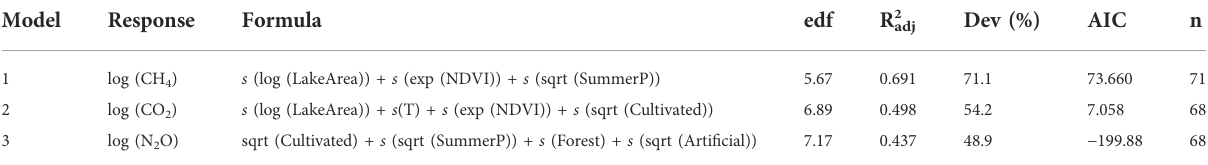
TABLE 1 Results of the generalized additive models (GAMs) calculated for biogenic saturation of CH 4 , CO 2 , and N 2 O using both linear terms and smoothers (indicated with s before the variable). Edf: effective degrees of freedom. R 2 adj: R-squared adjusted for the number of predictors in the model. Dev: deviance explained by each model in %. AIC: Akaike information criterion.